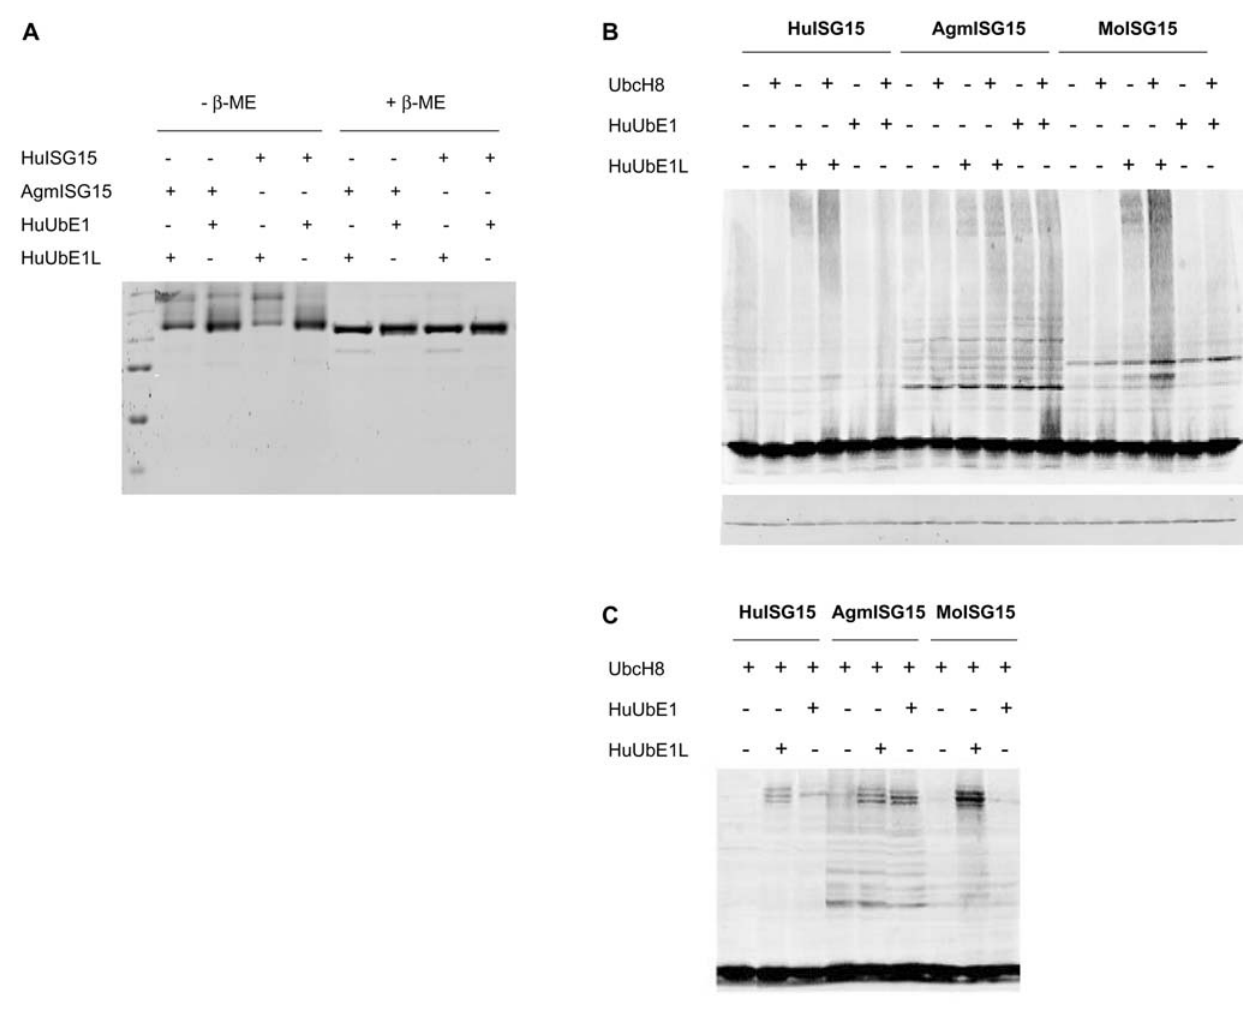
Figure 7. Promiscuity of the Activating enzyme of Ub in activating AgmISG15. (A) In vitro assay revealing the capability of AgmISG15 to form thiolester bonds with UbE1, contrary to HuISG15. 2.5 m M UbcH8 was incubated with 200 nM of either UbE1 or UbE1L, and 7.5 m M of either mature Hu- or AgmISG15 under conditions as described in Materials and Methods. The samples were divided in two aliquots; and were subjected to SDS-PAGE under non-reducing or reducing conditions. The proteins were stained with IRDye Blue protein stain and visualized using the Odyssey infrared imaging system. The extra band representing thiolester formation between UbE1 and AgmISG15 is flanked by two asterisks. These thiolester bonds are disrupted by the addition of reducing agent (here b -ME). (B) UbE1 can efficiently activate AgmISG15, but not Hu or MoISG15. HekT cells were transfected with an empty vector, or combinations of vectors encoding HuUbE1L, HuUbE1 and UbcH8 together with HuISG15, AgmISG15 or MoISG15 as indicated. The total ISGylation patterns were evaluated by Western blot analysis using the FLAG tag of the ISG15 proteins. Equal loading was confirmed by actin staining. (C) Same as (B), but the experiment was performed in COS cells. Only co-transfections with UbcH8 are shown.